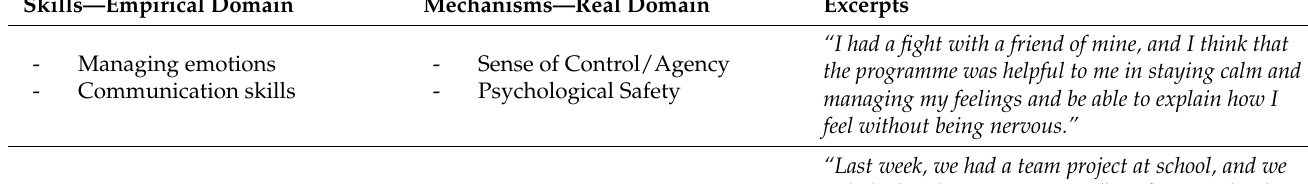
Table 5. Examples of Critical/Memorable Incidents (Excerpts) involving mechanisms for transferabil- ity (Mechanisms—real domain) of leadership skills (Skills—empirical